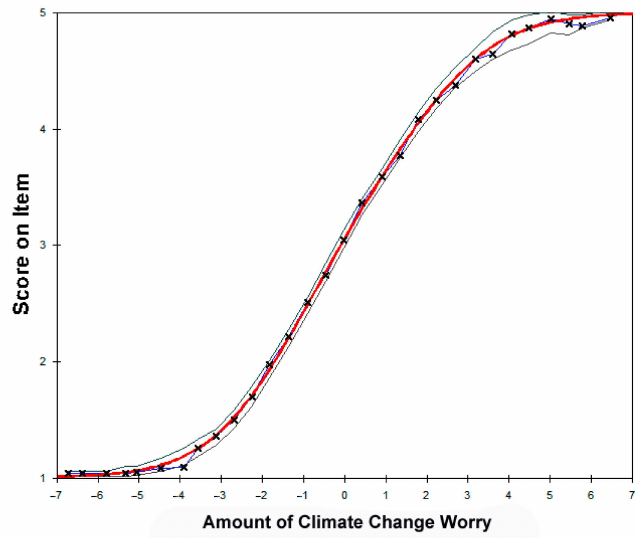
Figure 3. Test characteristic curve for the ten CCWS